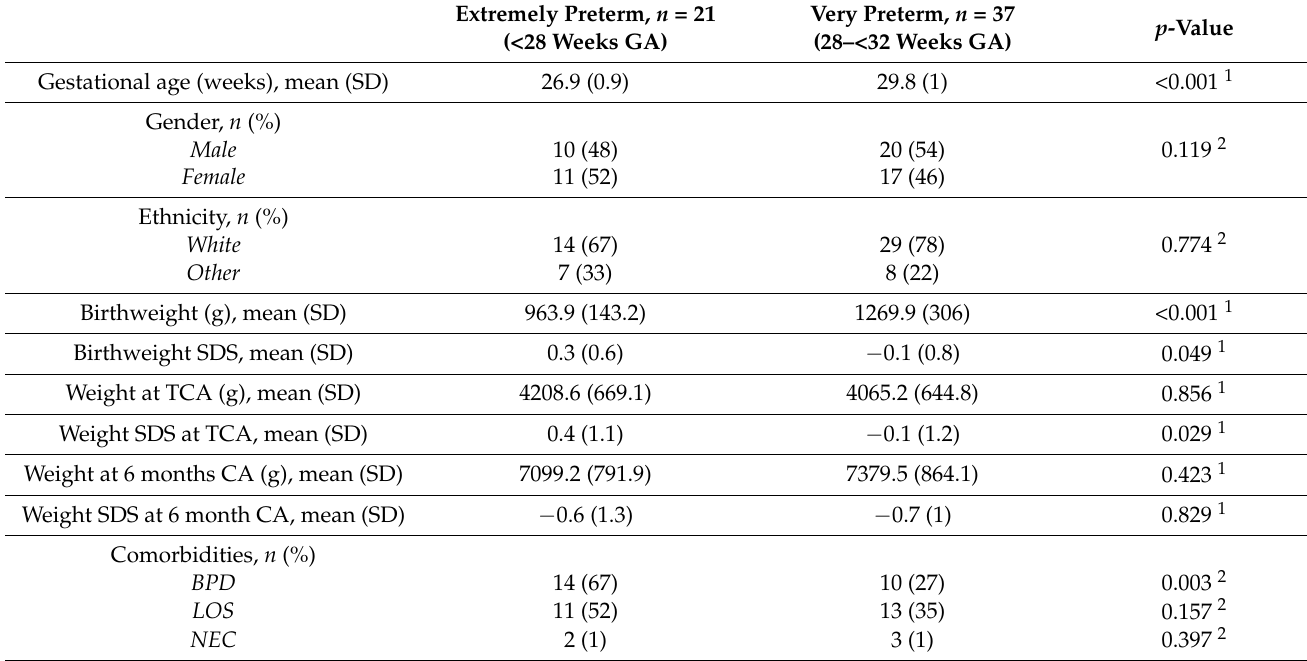
Table 2. Characteristics of the preterm cohort.